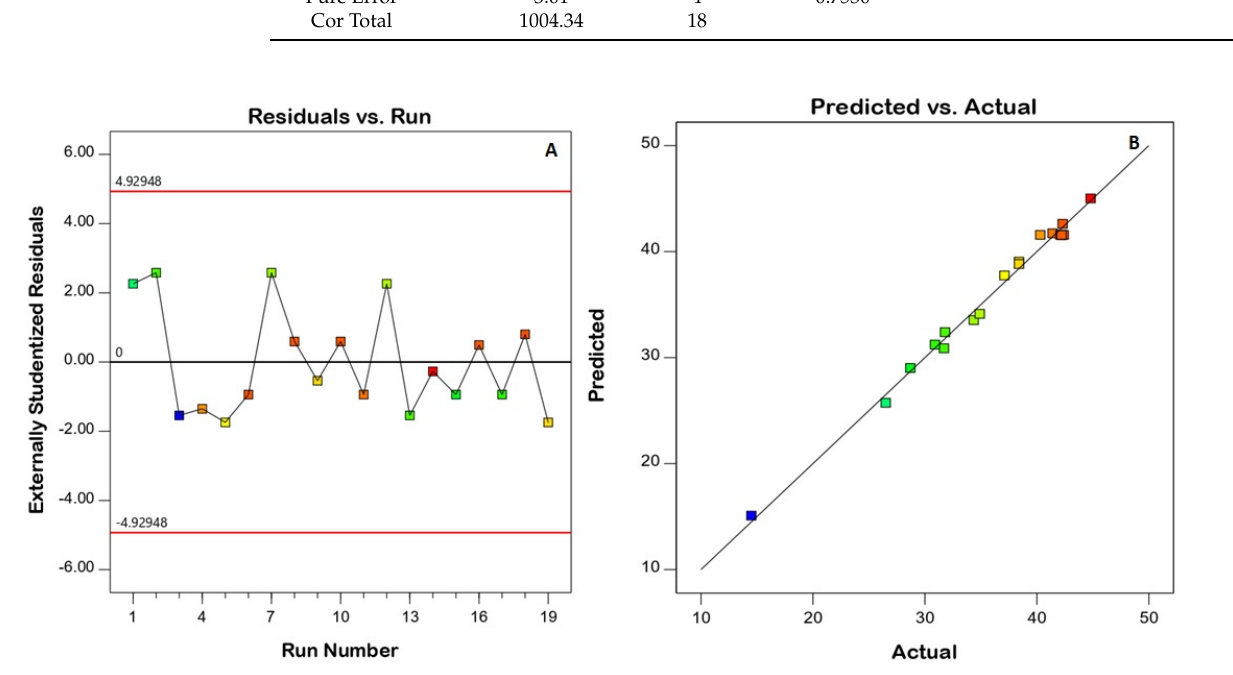
Figure 3. Diagnostic plots for the quadratic model for the zeta potential of resveratrol nanoemulsions. ( A ) Residuals versus the run, ( B ) predicted versus actual values. Table 4. ANOVA for zeta potential of resveratrol nanoemulsion.